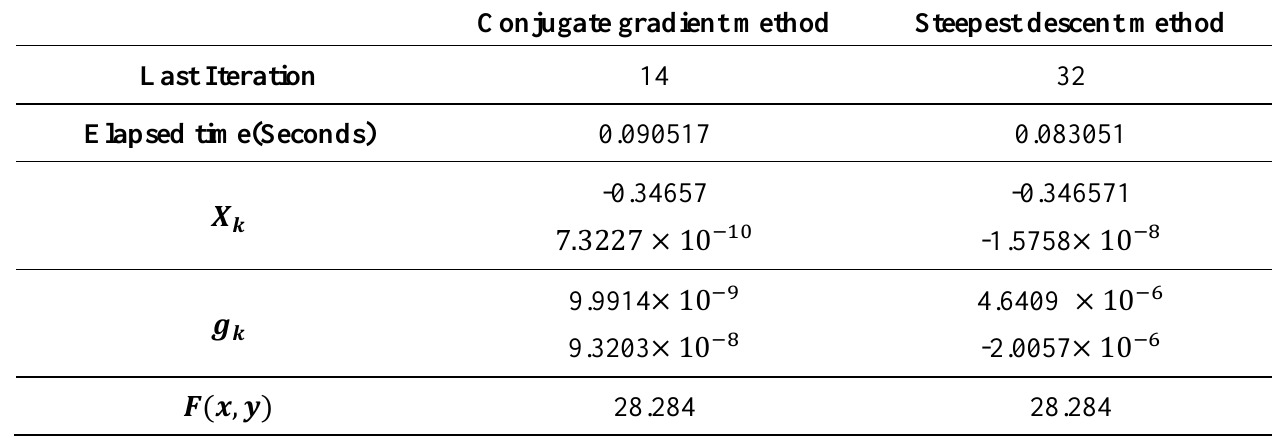
Table 5 In this table, the results of both methods are presented for Example